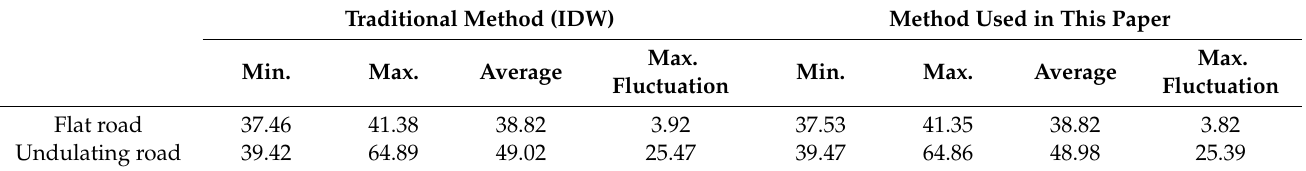
Table 1. Statistics of road elevation index